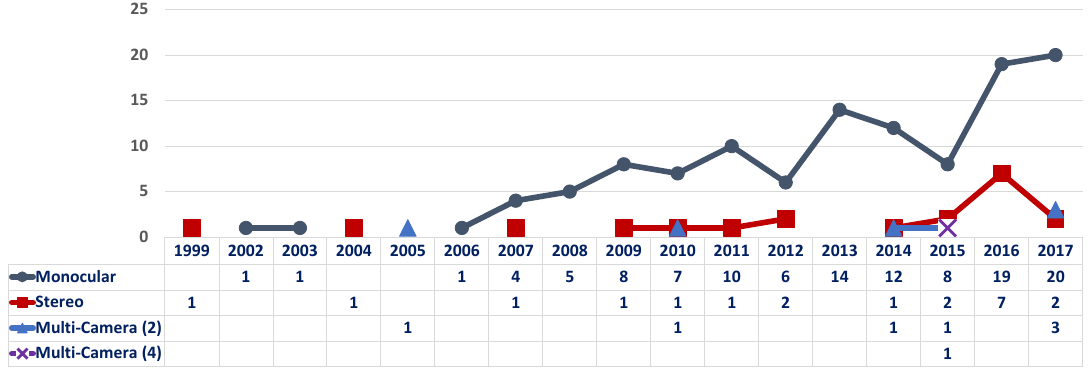
Figure 15. Annual trend per vision